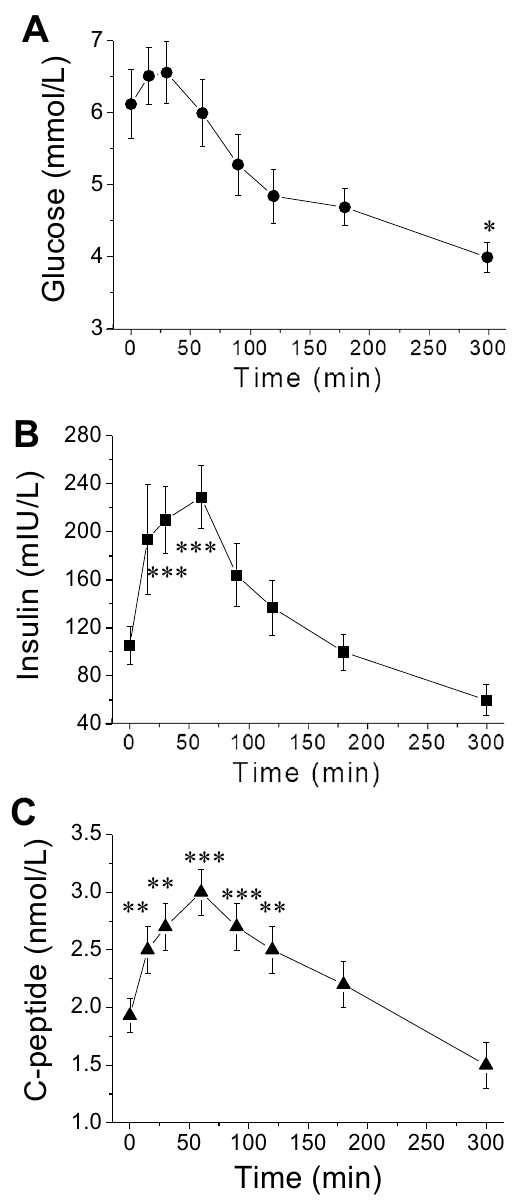
Figure 1. Time courses of the changes of plasma glucose, insulin and C-peptide following nasogastric meal administration at the time of 0 min. ( A – C) are the concentration changes of plasma glucose, insulin and C-peptide, respectively. Values are means ± SEM (n = 16). For the plasma glucose, insulin and C-peptide responses to the MMTT, there were significant time effects (RM One Way ANOVA; ** p < 0.01; *** p < 0.001; vs the baseline time 0) by Dunnett’s multiple comparisons